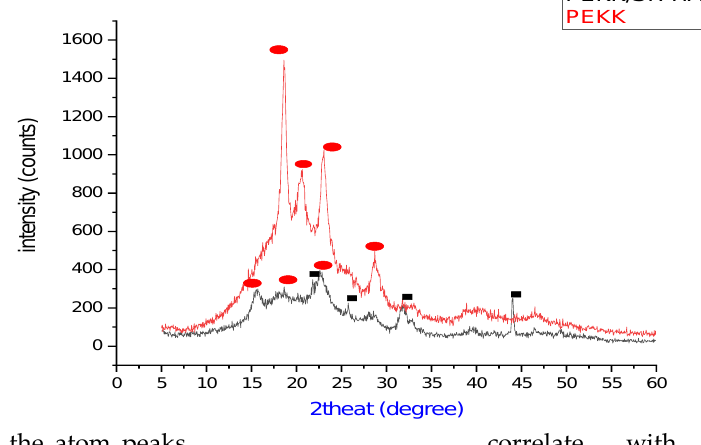
An EDX spectrum manifestation the atom peaks correlate with the greatest X-rays received energy levels of PEKK and PEKK coating with SR HA; the greater peak in a spec- trum, the more element concentrated, so the greatest level can be as seen in fig ( 3).